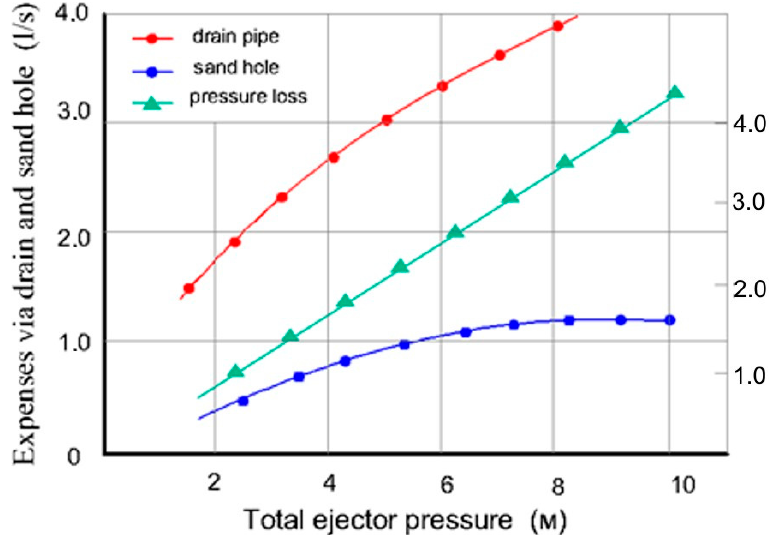
Figure 4. Loss redistribution between the discharge holes of the hydrocyclone.